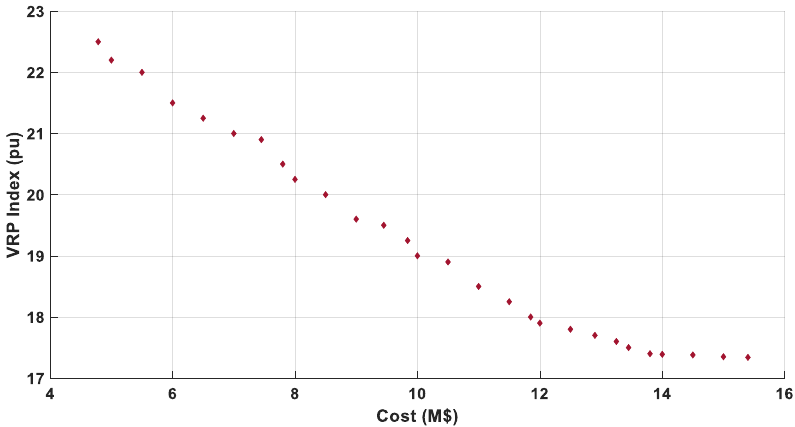
Figure 21. Optimal pareto solution for 123-bus system.